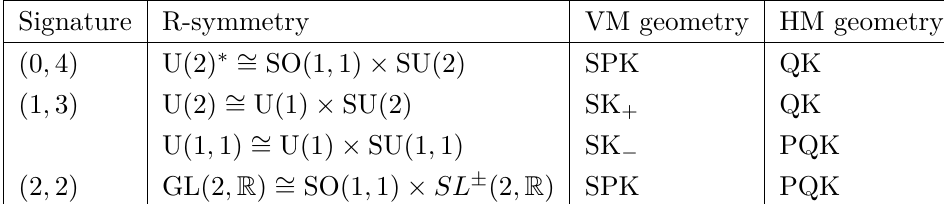
Table 1 . Four-dimensional N = 2 supersymmetry algebras, their R-symmetry groups and their scalar geometries. We use the acronyms SK = special Kähler, SPK = special para-Kähler, QK = quaternionic Kähler and PQK = para-quaternionic Kähler. See section 2.2 for further explanations.